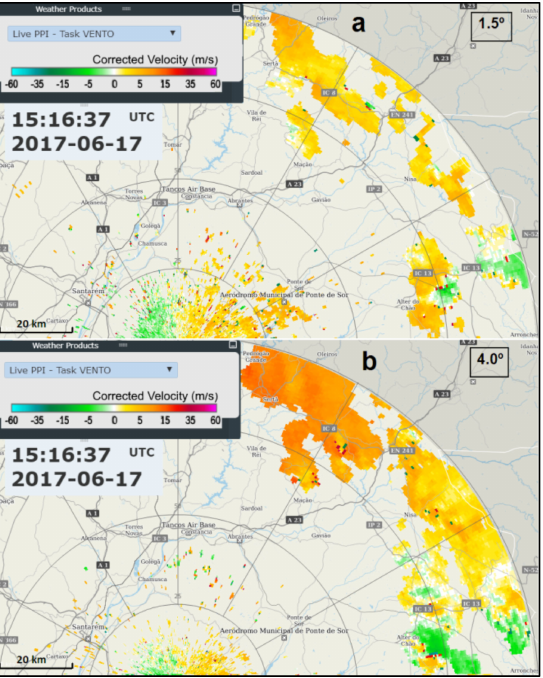
Figure 9. PPI of the storm-relative velocity, 1.5 ◦ tilt ( a ) and 4.0 ◦ tilt ( b ), 15:16 UTC, 17 June 2017, C/CL